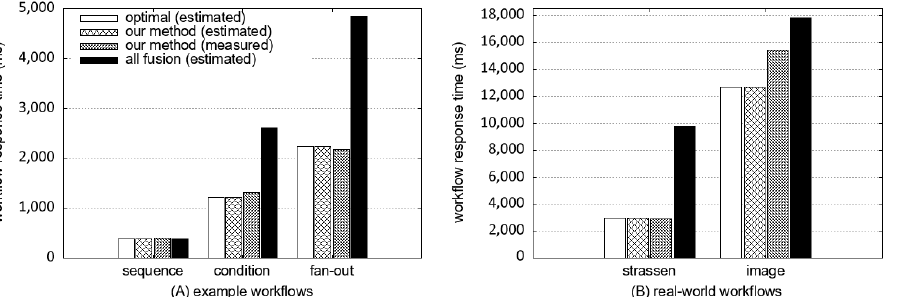
Figure 13. Comparing the estimated response time of our model with measured response time (ground truth) of each workflow in this